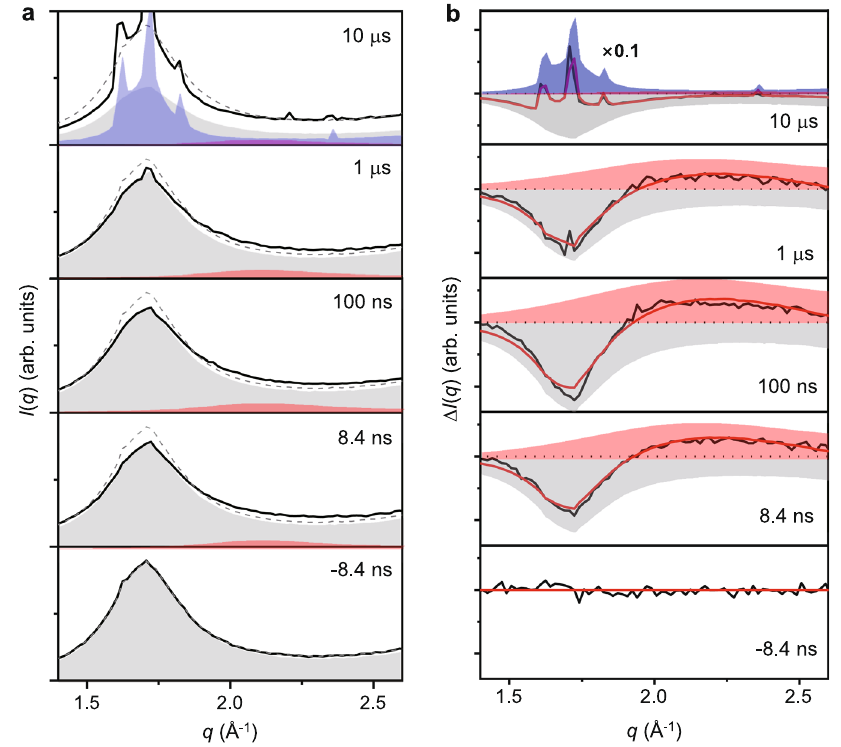
Fig. 3 | Structure factor before and after heating LDA. a Experimental x-ray scattering intensities, I ( q ),of LDAsamples measured before(gray dashed line) and after the laser excitation (black solid line). Data obtained at IR pump/x-ray probe delay times of Δ t = − 8.4 ns to 10 μ s are shown. Each curve is obtained from the average of I ( q ) over three independent x-ray shots. The contributions from LDA, HDA, and crystalline ice are indicated as gray, red, and blue shaded areas,